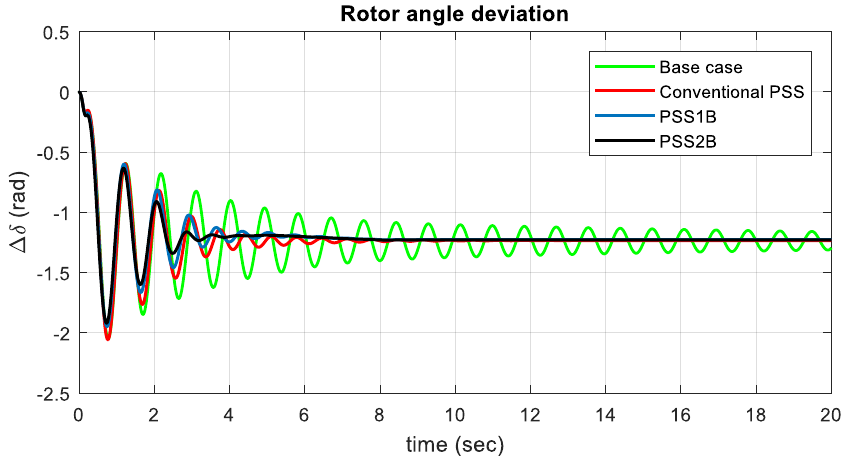
Figure 14. Rotor angle deviation ( ∆𝛿 ) of the power system at normal loading condition.